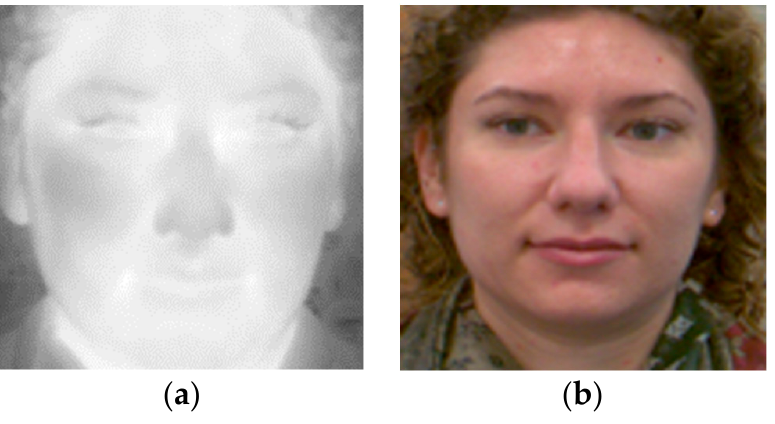
Figure 1. Sample face images from the D4FLY dataset: ( a ) thermal infrared; ( b ) visible spectrum.